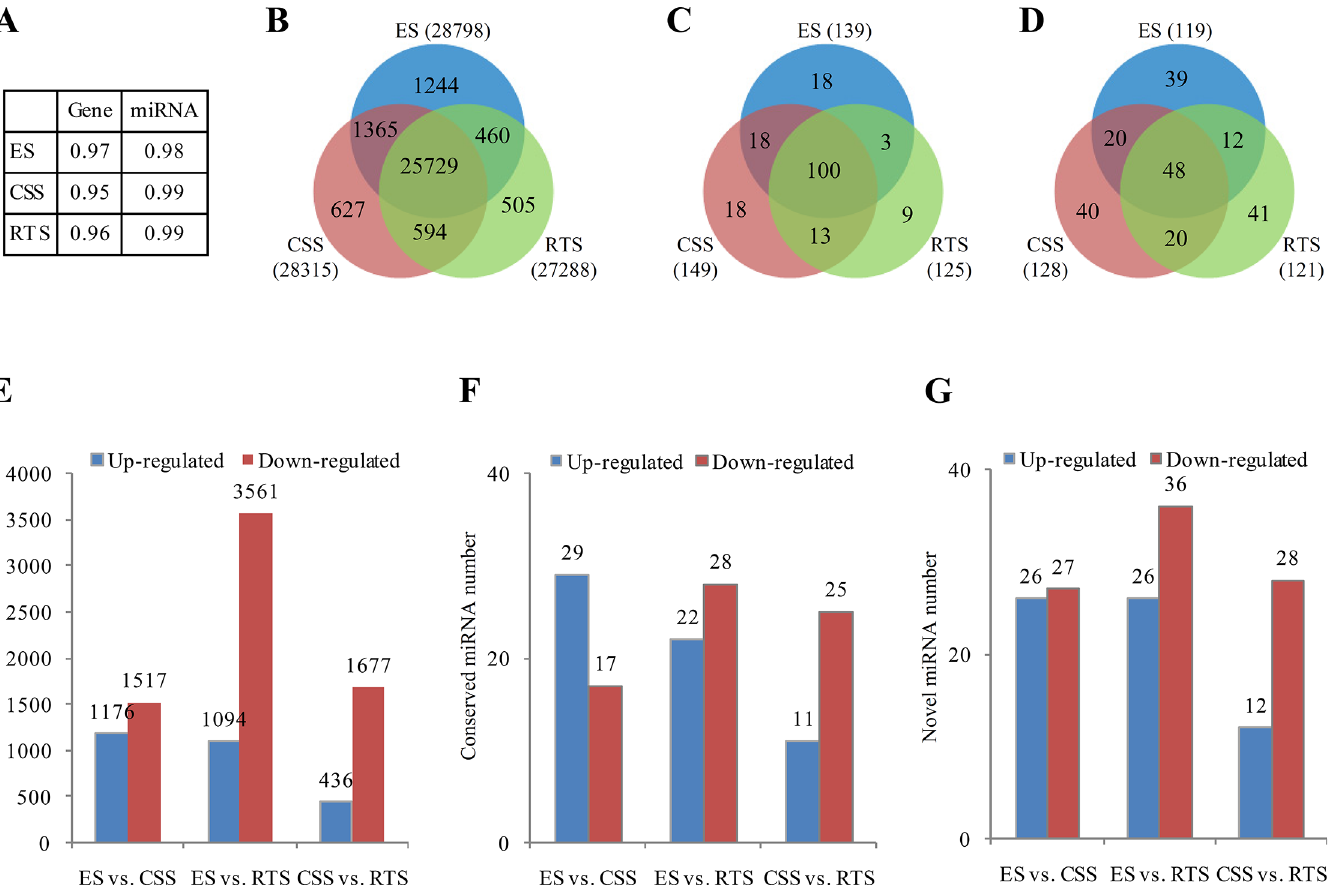
Fig 1. Characterization of gene and miRNA expression patterns among different stages of tuberous root in turnips. (A) Correlation coefficients of two biological duplicates; (B) Venn diagram analyses of stage specific genes in tuberous root of turnips; (C) Venn diagram analyses of stage specific conserved miRNA in tuberous root of turnips; (D) Venn diagram analyses of stage specific novel miRNA in tuberous root of turnips; (E) Differentially expressed genes across all libraries; (F) Differentially expressed conserved miRNAs across all libraries; (G) Differentially expressed conserved novel miRNAs across all